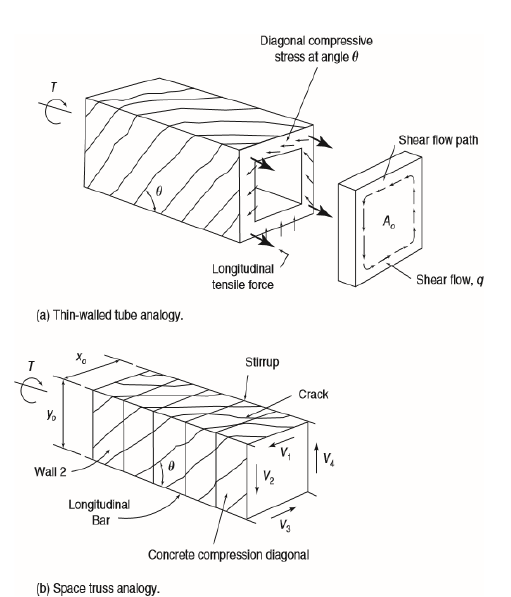
Figure 5: Thin-walled tube analogy and generalized space truss [12].